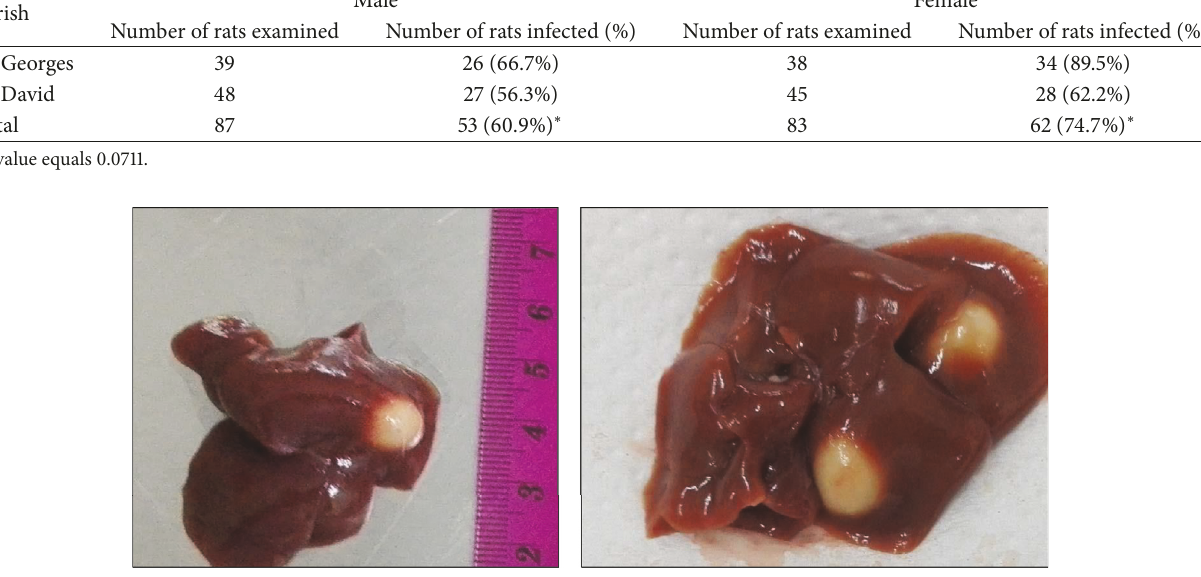
Figure 1: Multiple cysts of C. fasciolaris in liver.